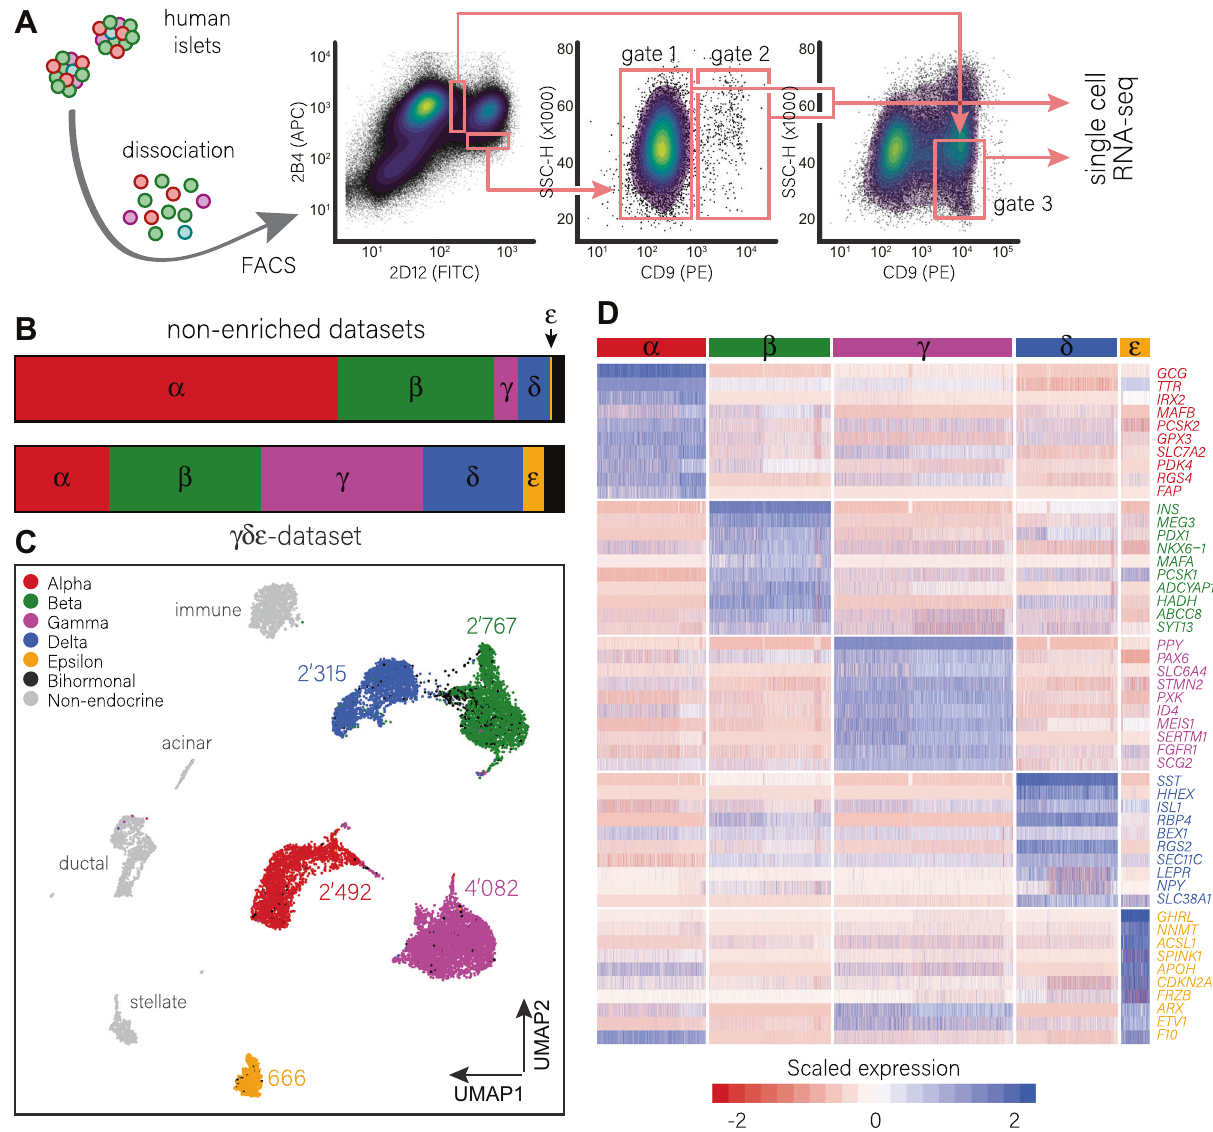
Fig. 2 Generation and validation of a single-cell transcriptomics dataset enriched for γ -, δ - and ε -cells. A Strategy for the enrichment of human γ -, δ - and ε -cells. Dissociated human islets were labelled with cell-surface antibodies and the different fractions were processed and collected as described. Cells from gate 2 were complemented with cells from gate 1 to 15,000 cells ( γ / ε fraction). The δ -fraction of 15,000 cells was collected in gate 3. B Compared to the unsupervised islet cell collection used to produce non-enriched datasets, our dataset contains smaller fractions of α - and β -cells but larger fractions of γ -, δ - and ε -cells. C UMAP dimensional reduction representation of the fi nal dataset. Cells are colour-coded based on their identity. Populations of α -, β -, γ - and δ - cells each contain thousands of cells, while the ε -cell fraction contains hundreds of cells. D Heatmap showing a representative selection of manually selected identity markers for each of the cell types. Low expression levels are marked in red, high expression in blue. The colour bar above indicates the speci fi c populations: α -cells (red), β -cells (green), γ -cells (magenta), δ -cells (blue) and ε -cells (orange). Source data are provided in the supplemental tables and as a source data fi